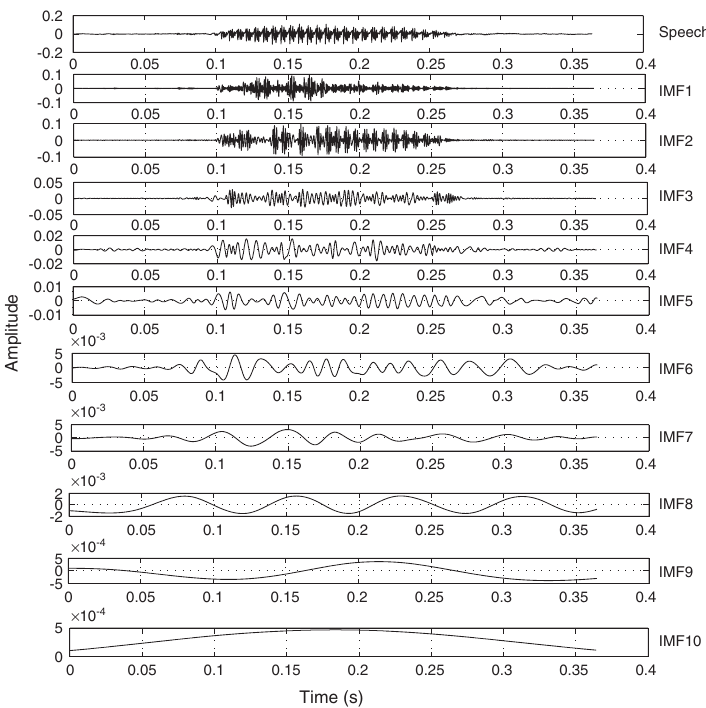
Figure 1. Illustration of the EMD of the Real-World Speech Utterance “ Car